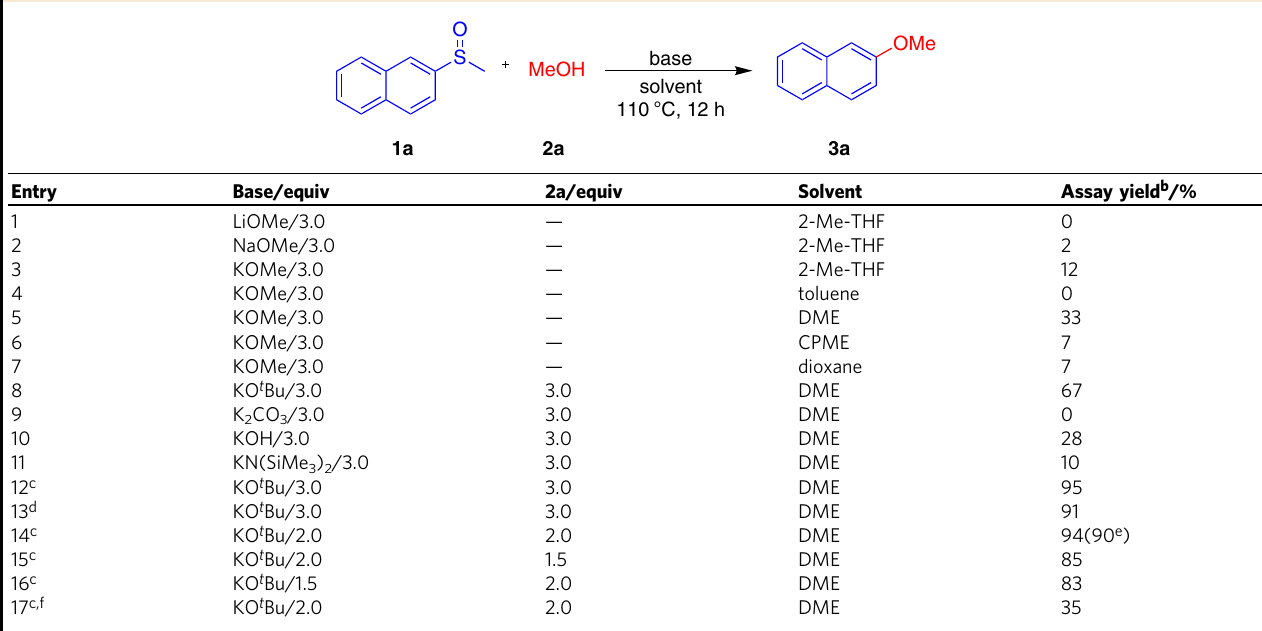
Table 1 Optimization for transition-metal-free cross-coupling reaction between 1a and 2a a